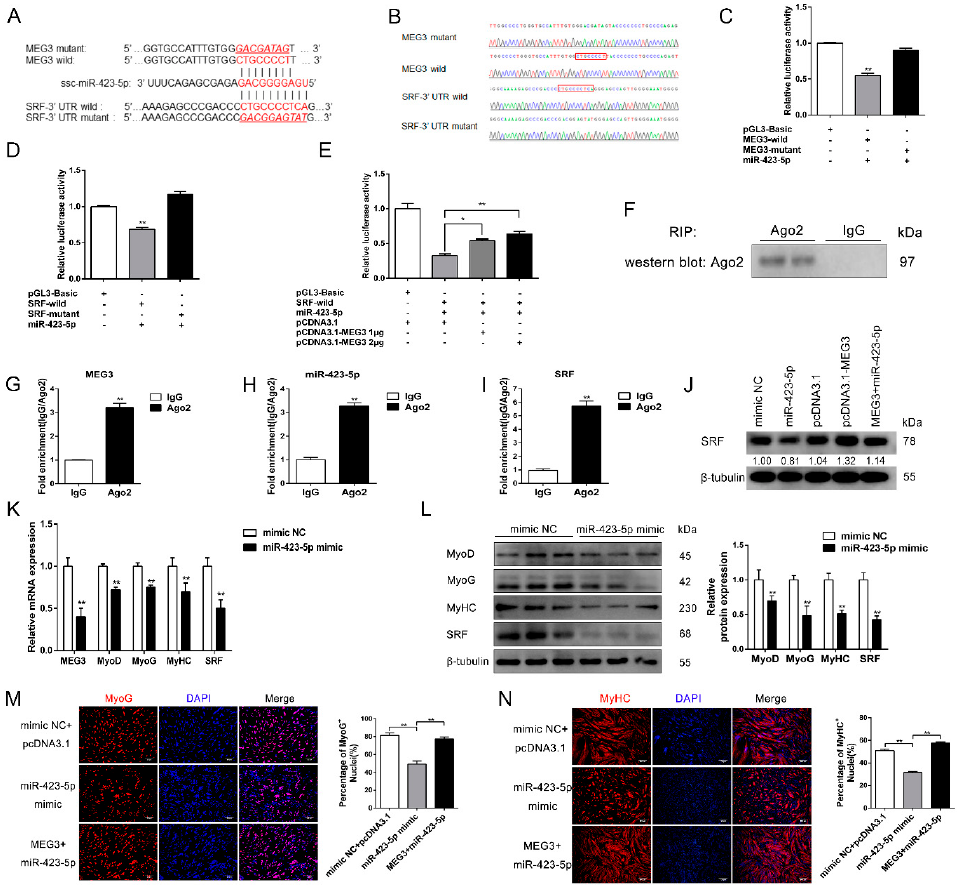
Figure 5. MEG3 is a target of miR-423-5p during myoblast di ff erentiation. ( A ) The miR-423-5p target sequence on MEG3 and 3 (cid:48) UTR of SRF . The red letters represent the seed region of miR-423-5p and its target region. The underlined word letters in red show the mutated site. ( B ) The sequencing results of MEG3 and SRF -3 (cid:48) UTR wild and mutant types. The red boxes represent the mutant bases. ( C ) Luciferase activities assay in PK15 cells were measured after transfection for 48 h with MEG3 wild or mutant type pGL3-Basic plasmids together with miR-423-5p mimic. ( D ) Luciferase activities assay in PK15 cells were measured after transfection of 48 h with SRF wild or mutant type pGL3-Basic plasmid together with miR-423-5p mimic. ( E ) Wild type of MEG3 fragments rescued the relative luciferase activities of SRF wild-type pGL3-Basic plasmid in a dose-dependent manner. ( F – I ) RIP assay was conducted with Ago2 antibody. Protein level was detected by IP-Western Blot ( F ). MEG3 ( G ), SRF ( H ), and miR-423-5p ( I ) were detected by qPCR. ( J ) The protein expression level of SRF showing MEG3 overexpression increases SRF expression and relieves the inhibitory e ff ect induced by miR-423-5p on SRF . ( K , L ) Relative mRNA ( K ) and protein expression level ( L ) changes of MEG3, SRF, and the di ff erentiation marker genes after transfection with miR-423-5p mimic or mimic NC. ( M , N ) Immunofluorescence staining of MyoG ( M ) and MyHC ( N ) in porcine satellite cells di ff erentiated for 48 h after transfection with miR-423-5p mimic, MEG3 + miR-423-5p mimic, or corresponding NC. Statistical results of the positively stained cells show that miR-423-5p significantly reduces the percentage of MyoG and MyHC , while the co-transfection with MEG3 can recover their reduction. Scale bar of ( M ): 50 µ m. Scale bar of ( N ): 100 µ m. The numbers below the Western blots ( J ) mean the fold change of SRF protein quantities related to the mimic NC group. The relative mRNA levels were normalized to those of the control 18S rRNA . The relative protein levels were normalized to those of the control β -tubulin . Error bars represent mean ± SEM of three biological replicates. Statistical significance of di ff erences was assessed by Student’s t -test. * p < 0.05, ** p < 0.01. NC, negative control. UTR, untranslated regions. RIP, RNA immunoprecipitation. qPCR, quantitative polymerase chain